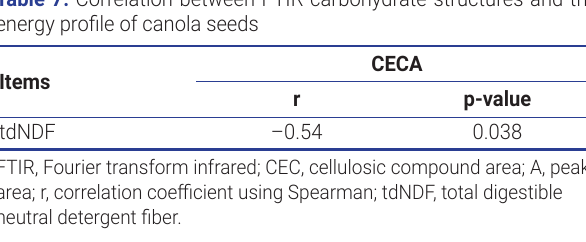
Table 8. Correlation between FTIR carbohydrate structures and the NRC system for canola meals